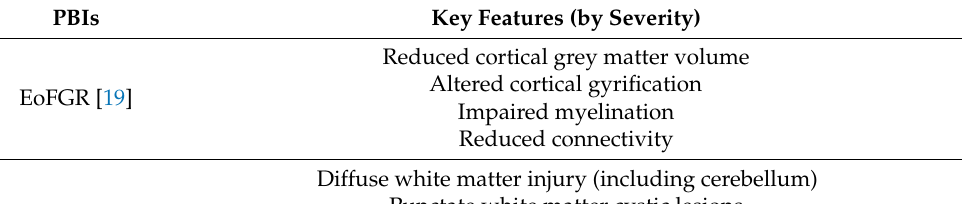
Table 1. Brain structures predominantly affected in MRI and/or post-mortem studies of PBIs. PBIs Key Features (by